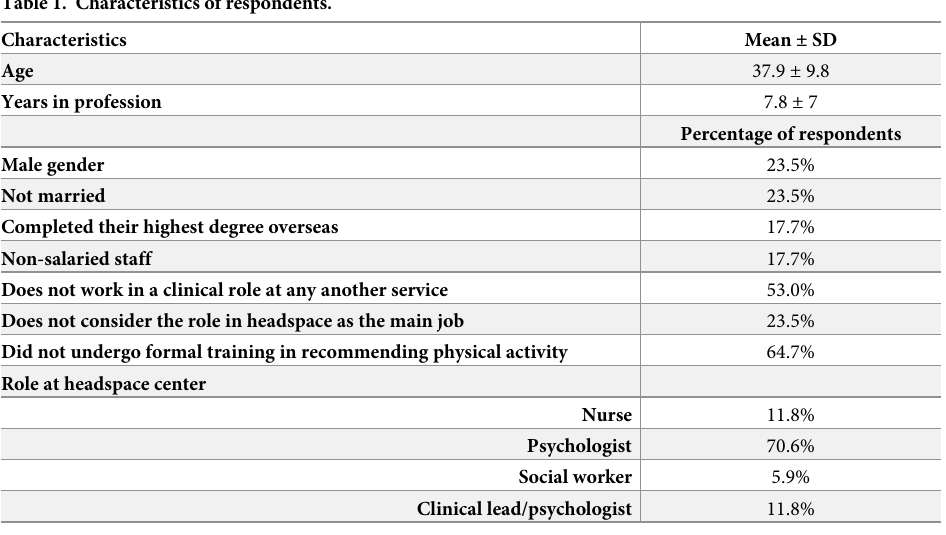
Table 1. Characteristics of respondents.